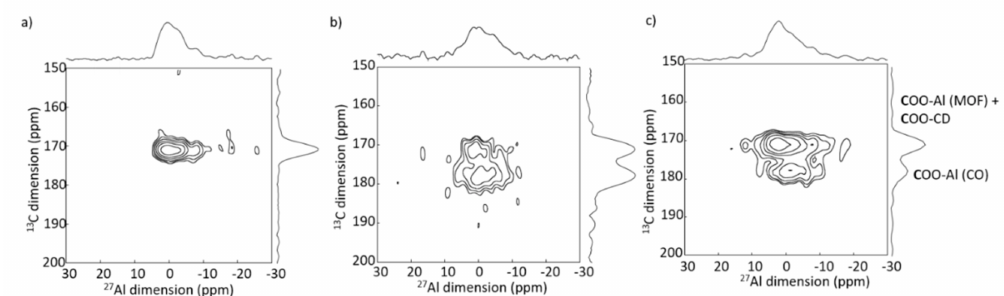
Figure 16. 2D 13 C- 27 Al D-HMQC 2D of ( b ) CD- 13 CO@nanoMIL-100(Al) and ( c ) DOX loaded CD- 13 CO@nanoMIL-100(Al). The spectrum recorded on pure ( a ) nanoMIL-100(Al) is shown for comparison